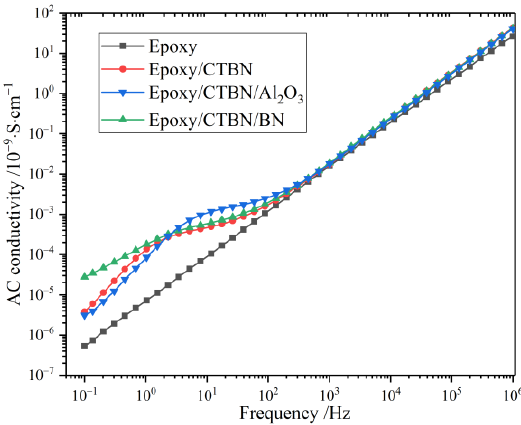
Figure 4. Frequency spectrum of AC conductivity of four kinds of samples at 25 ℃ .